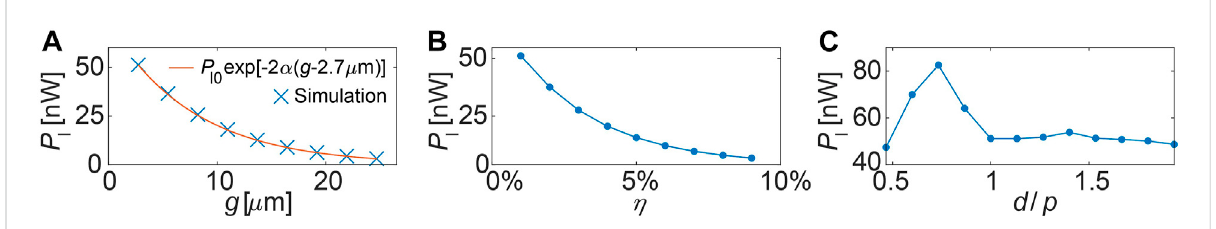
FIGURE 6 Simulationresultsoftheleftwardoutputpower P l asafunctionofthebeam-gratingdistance g (A) ,theelectronenergyspread η (B) ,andtheslab thickness d (C)